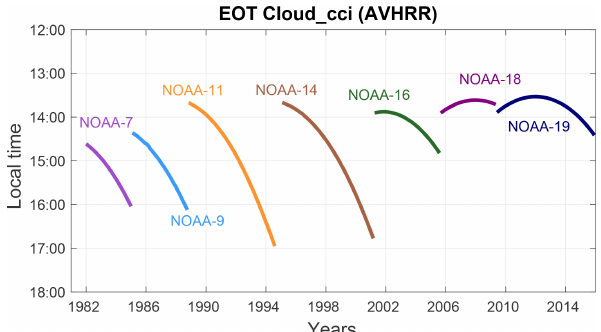
Figure 1. The local time of EOT of the daytime (ascending) nodes of the satellites used to create the Cloud_cci AVHRR-PM CDR. The figure is a modified version of the same data in Stengel et al.